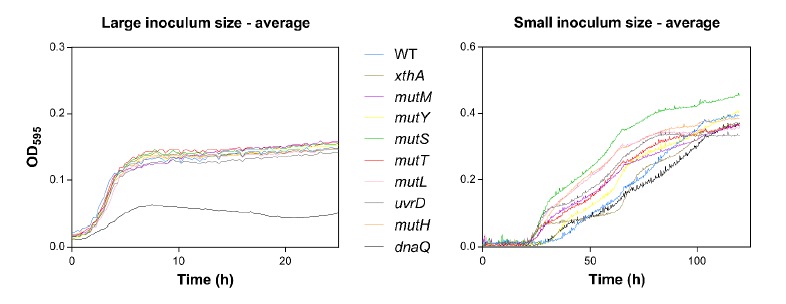
DOI:
http://dx.doi.org/10.7554/eLife.22939.026